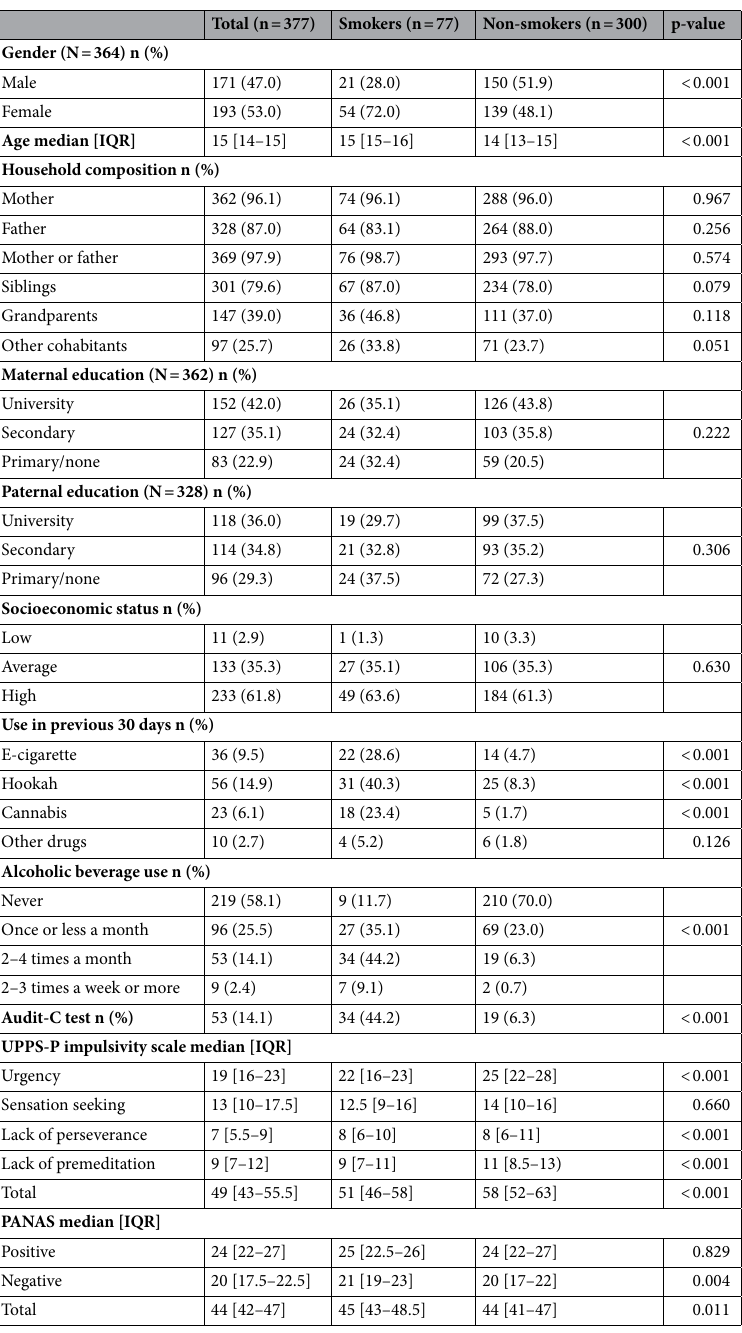
Table 1. Distribution of variables for the entire sample and according to cigarette use. IQR: interquartile range; UPPS-P: impulsive behaviour scale; PANAS: positive and negative affect